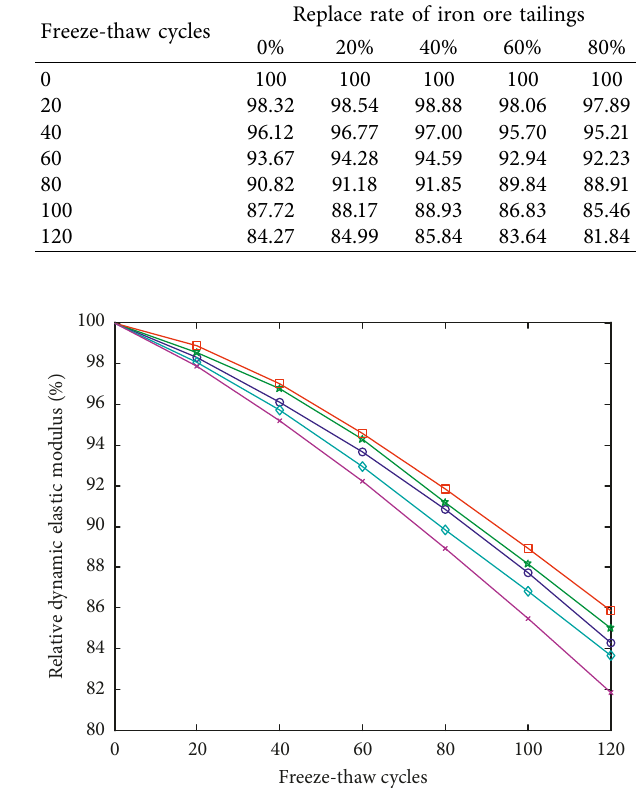
) of C30 iron ore n